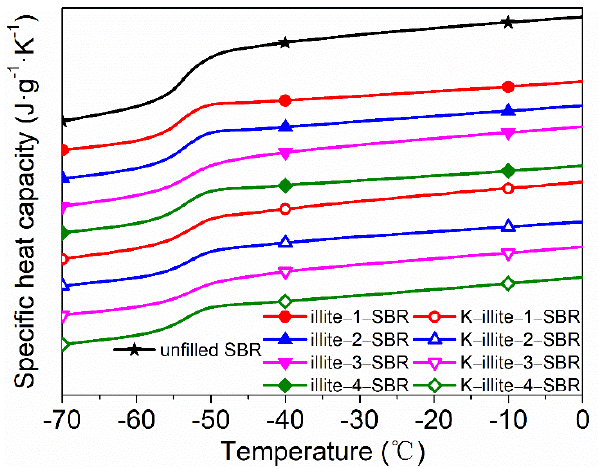
Figure 4. DSC thermograms showing the glass transition of SBR masterbatches.